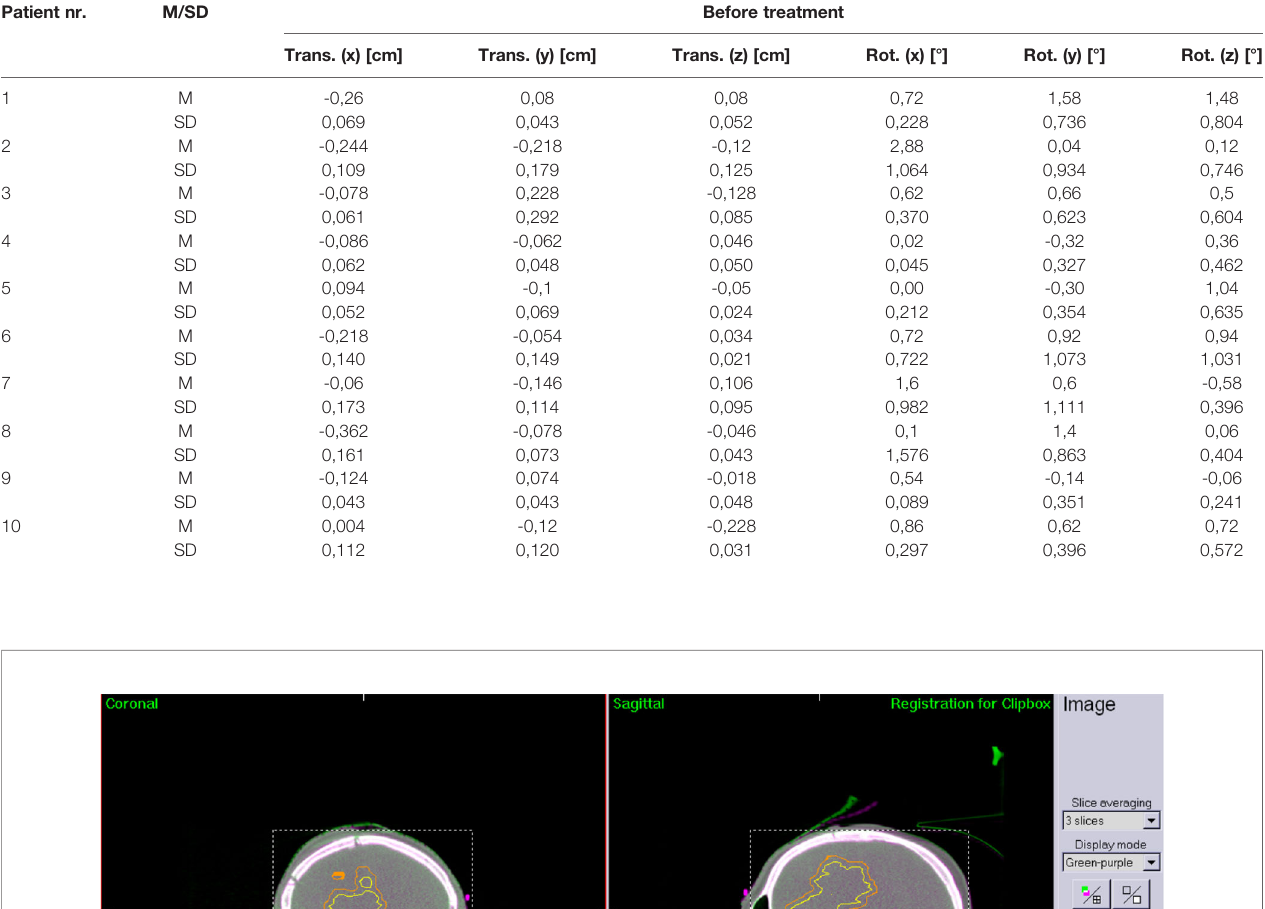
TABLE 2 | Mean and standard deviation of pre-treatment CBCTs per patient. Patient nr.